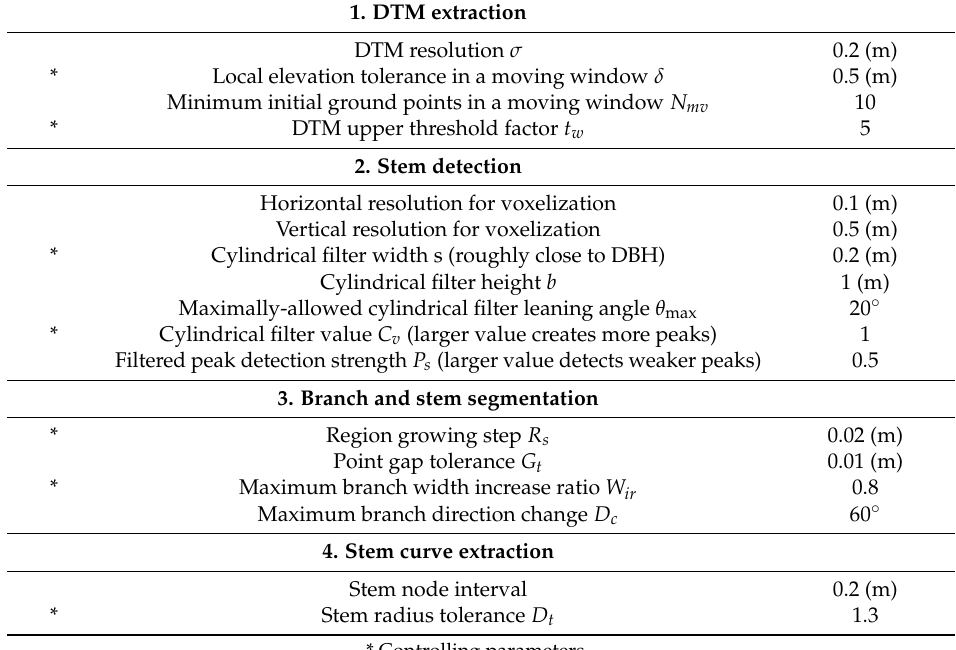
Table 1. Parameter and settings for automated stem attribute analysis from terrestrial laser scanning (TLS)